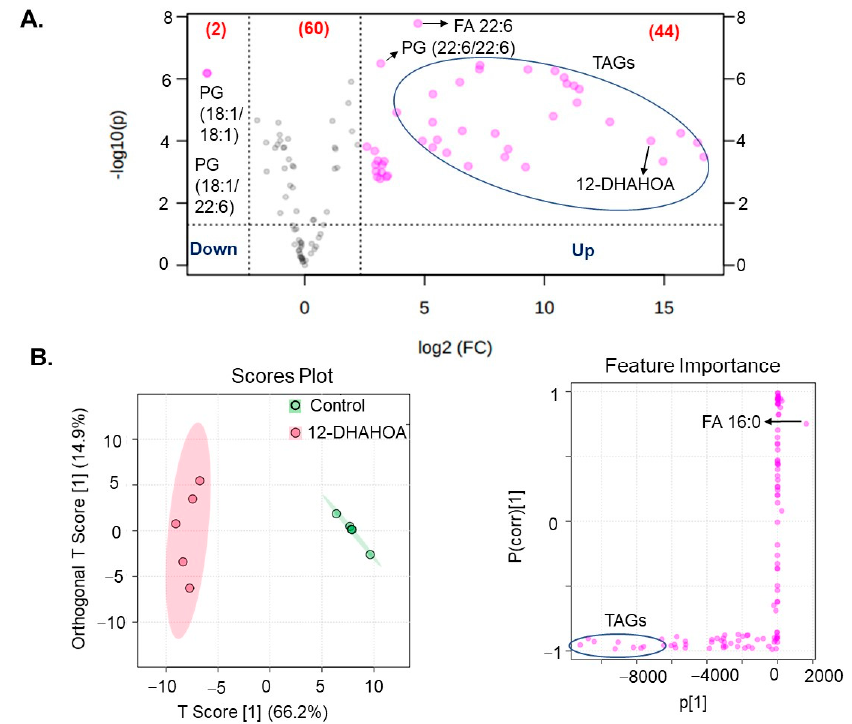
Figure 4. ( A ) Volcanic plot of all the annotated lipids (only species changed by 5-fold are highlighted with applied t -test of p < 0.05). ( B ) Orthogonal partial least squares discriminant analysis (OPLS-DA). Score plot and feature importance; colored circles display 95% confidence regions; Control ( n = 5) and 12-DHAHOA ( n = 5) (Predictive component 1: R2X = 0.662, R2Y = 0.965, Q2 = 0.954; Orthogonal component 1: R2X = 0.149 R2Y = 0.00218, Q2 = 0.0162; All components: R2X(cum): 0.811). Q2 and R2 values represent the predictability and goodness of fit, respectively.